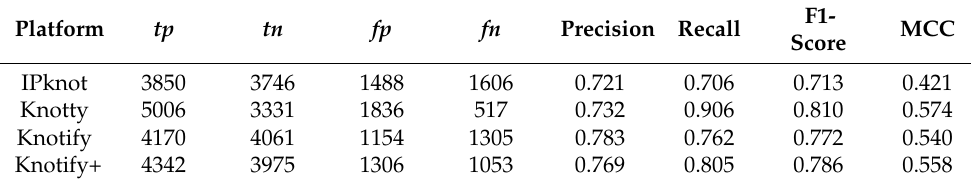
Table 3. The confusion matrix for each method in the entire dataset.